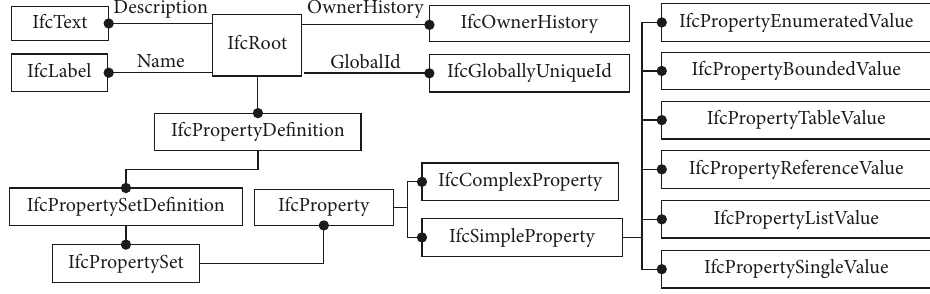
Figure 18: Inheritance definition of IfcProperty